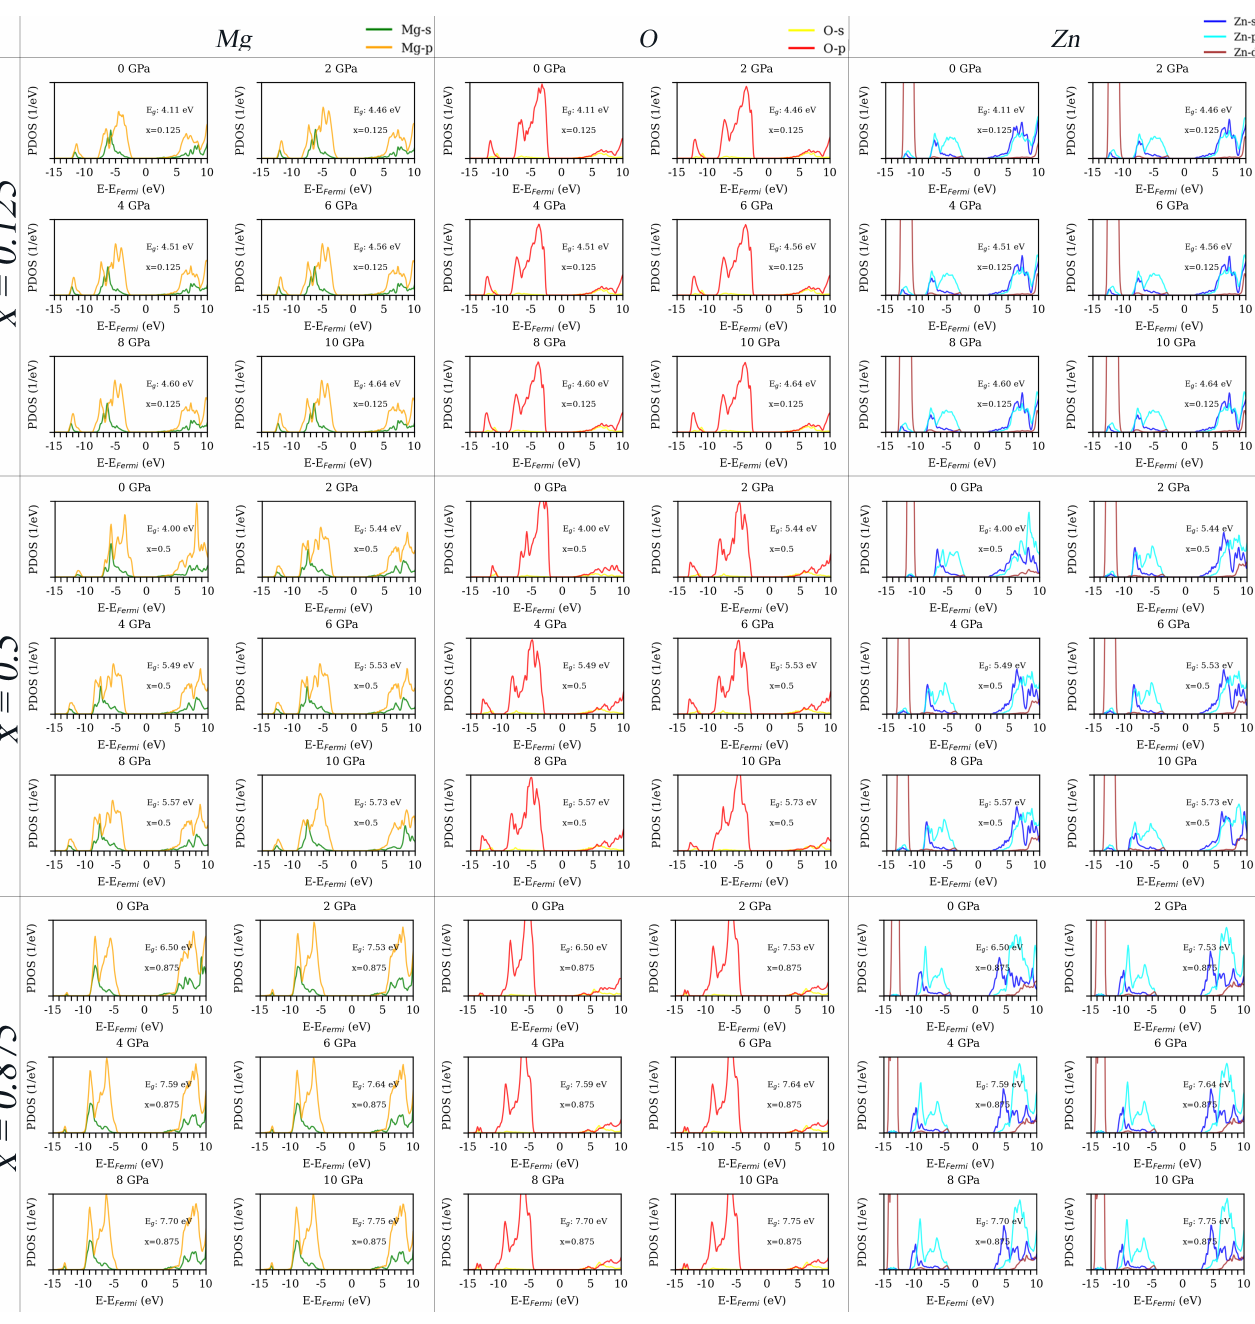
Figure A2. Partial density of states (PDOS) of wurtzite (WZ) Zn 1 − x Mg x O for WZ ZMO1 models at different concentration (x = 0.125, 0.5 and 0.875) with the pressure from 0 to 10 GPa in 2 GPa increments, which correspond to Figure